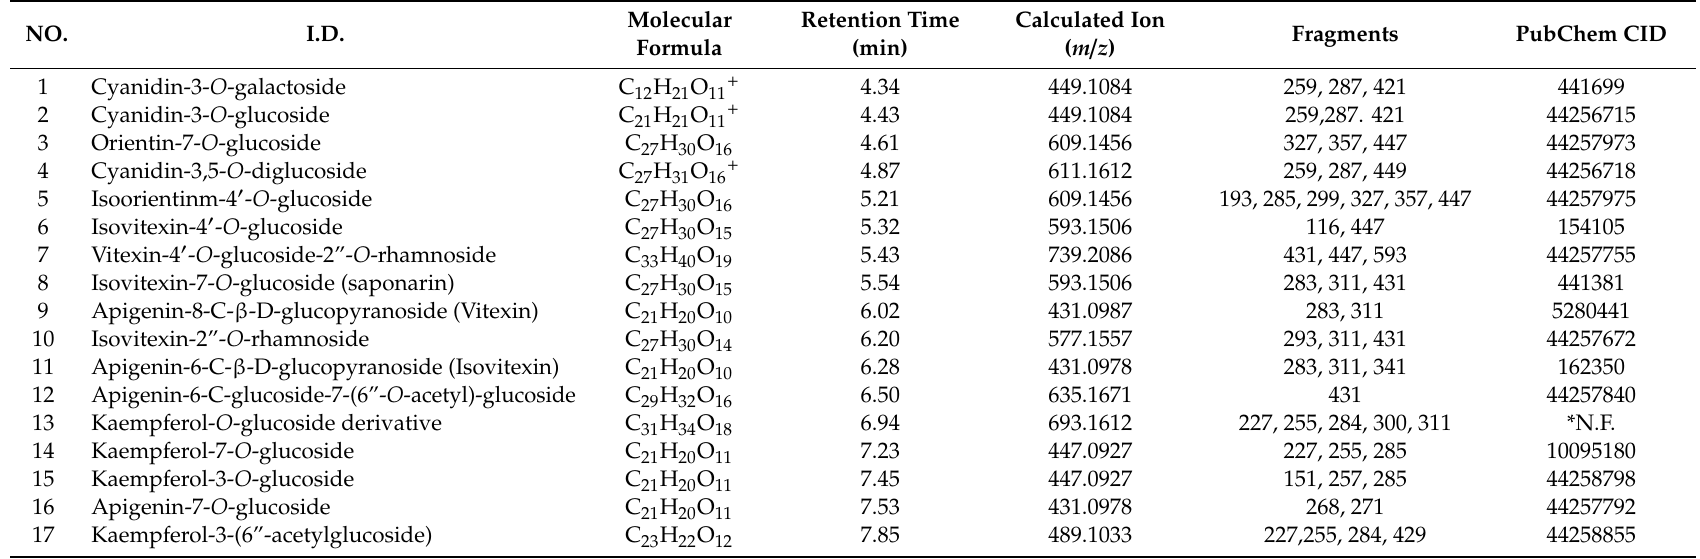
Table 1. Molecular formula, retention time, calculated ion, fragments and PubChem compound ID (CID) from PS and